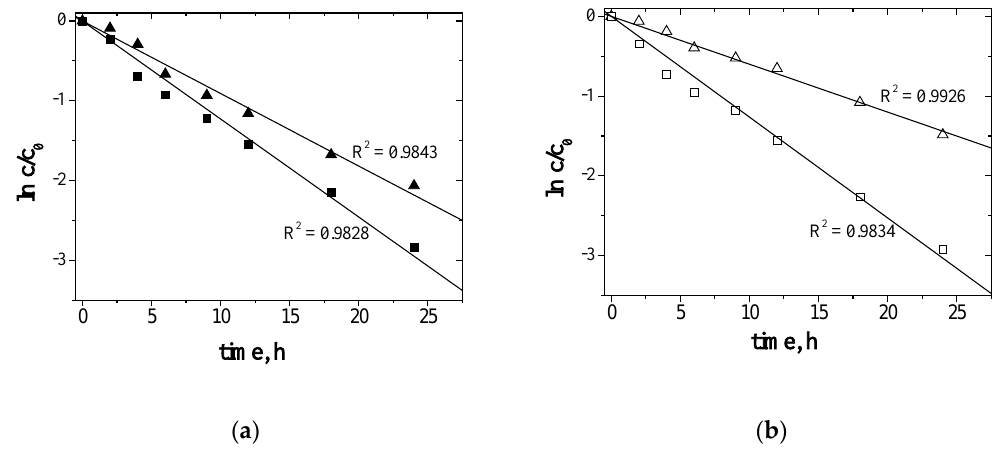
Figure 6. The relation of ln( c/c o ) versus time from the leaching solution for Zn(II) ( ■ , □) and Ag(I) ( ▲ , ∆ ) transport across PIMs with ( a ) ( ■ , ▲ ) 1-hexylimidazole ( 1 ) or ( b ) (□, ∆) 1 -hexyl-2-methylimidazole ( 2 ).